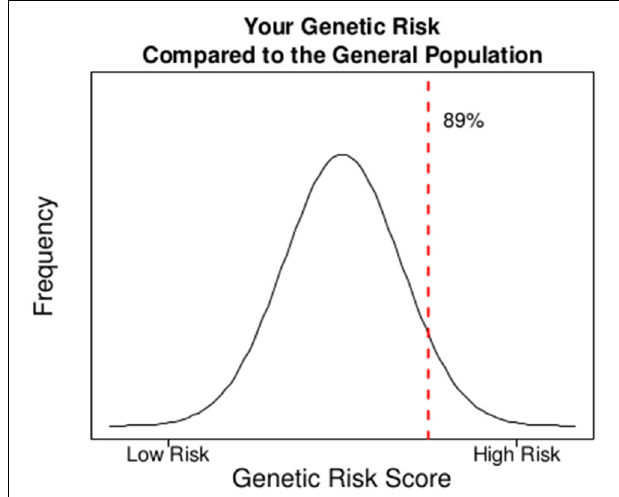
FIGURE 2 | A sample report on CHD risk for an individual in the ARIC study where the incorporation of genetic risk into the model of clinical risk potentially influences clinical management based on current